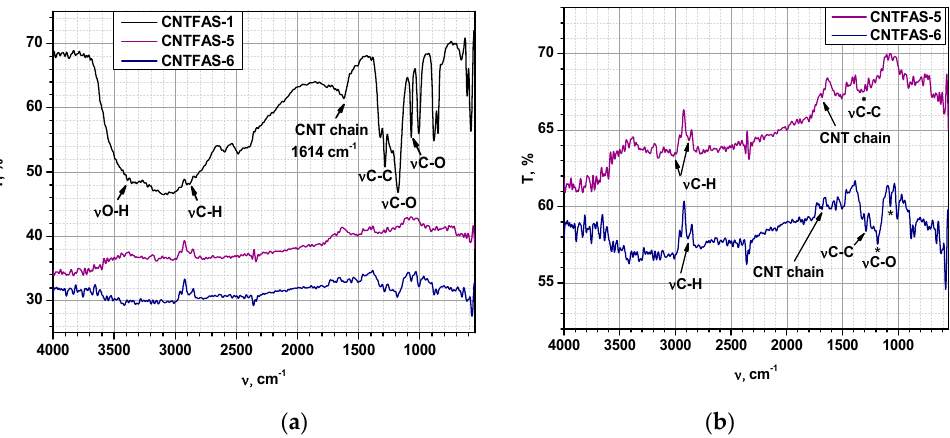
Figure 3. a) FT-IR spectra of CNT samples functionalized by acid treatment. Concentration of HNO 3 was 4M in the case of CNTFAS-1 and respectively 2M in the case of CNFAS-5 and CNTFAS-6 sam- ples. Concentration of H 2 SO 4 was 10M for CNTFAS-1 and CNTFAS-5 sample, respectively 5M for CNTFAS-6 sample; b) detailed FT-IR spectra of CNTFAS-5 and CNTFAS-6 samples. FT-IR spectra of ZnO-CNT powders described in Table 2 are revealed in Figure 4. A